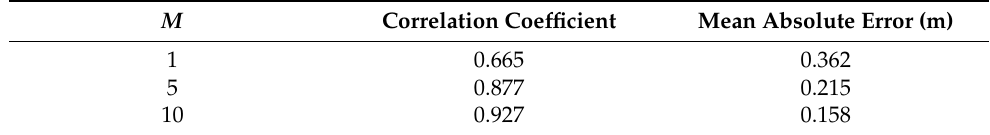
Table 2. Error statistics for nearly concurrent radar and buoy measurements.